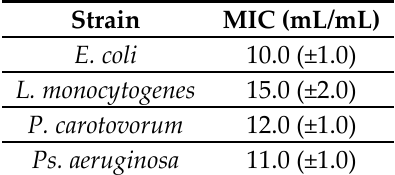
Table 1. Minimal inhibitory concentration ( μ L/mL) of the prickly pear seeds oil evaluated through the resazurin test, as reported in the Materials and Methods.